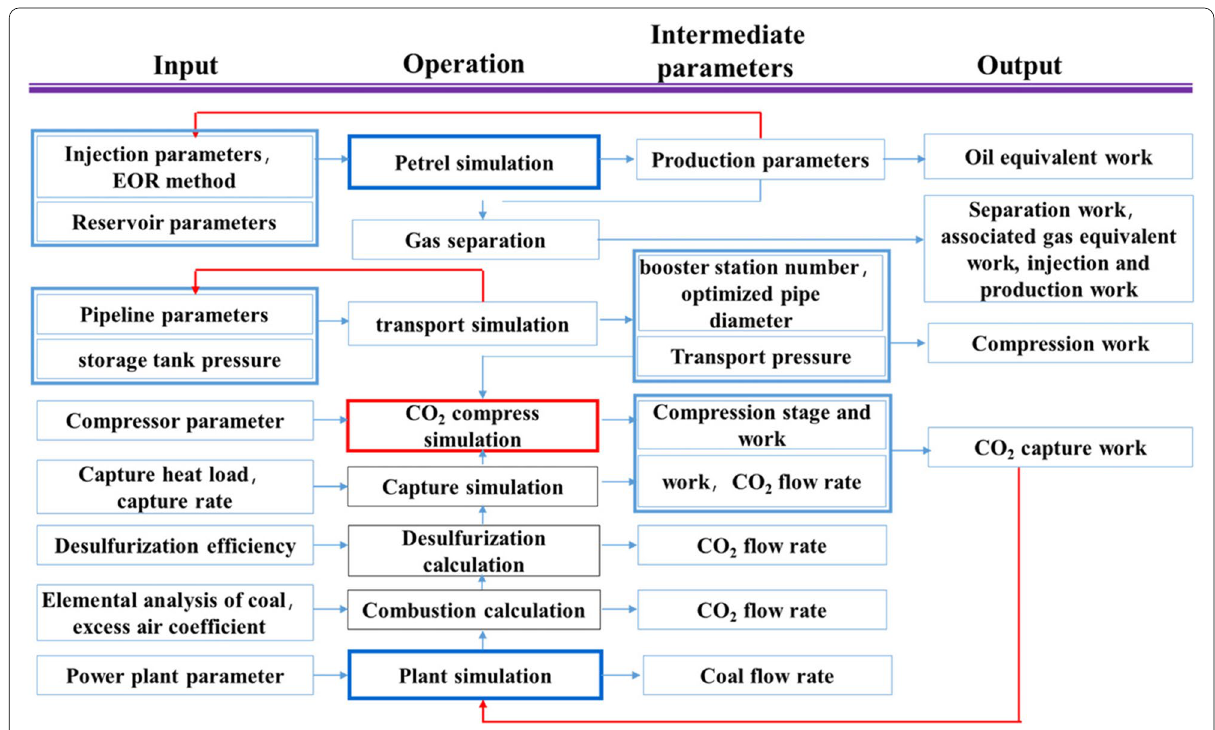
Fig. 7 Flow chart of the energy budget calculation for the full‑chain CCUS‑EOR system